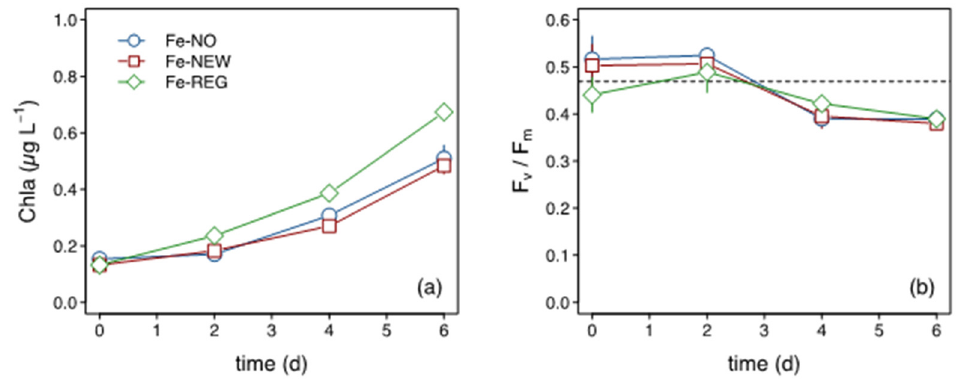
Figure 3. Time course of ( a ) Chl a concentration and ( b ) F v /F m . The horizontal dotted line in ( b ) corresponds to in situ F v /F m at the start of the incubation.